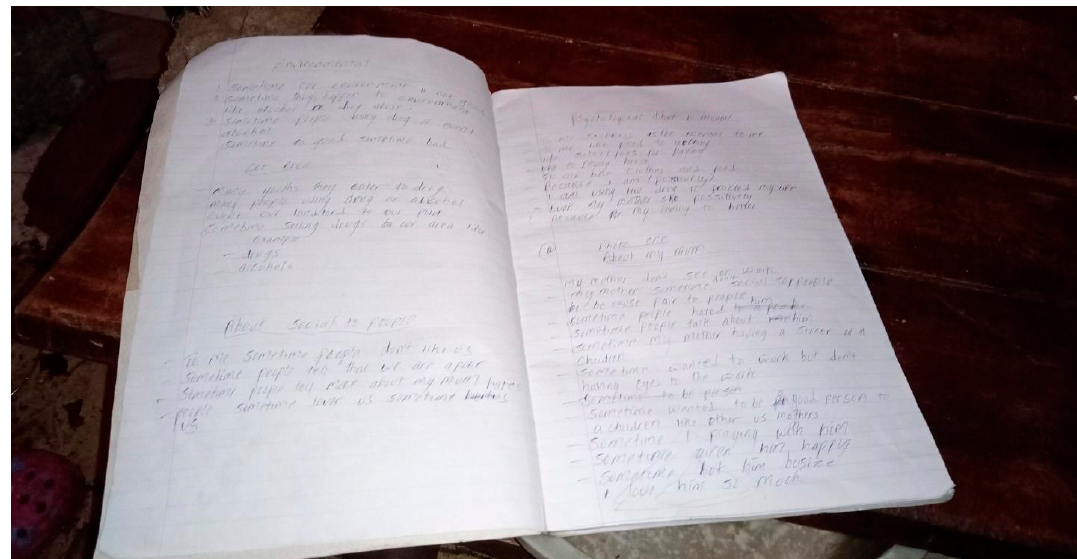
Figure 8. “Sometimes, when in school, my thoughts are still at the situation back at home. I am constantly in conflict [about] whether I should be in school or proving for my family and help my mum. The book there is to remind me that education is still a pillar of my life in my quest to sustain my family” (Robert, 17-year-old boy, Korogocho).